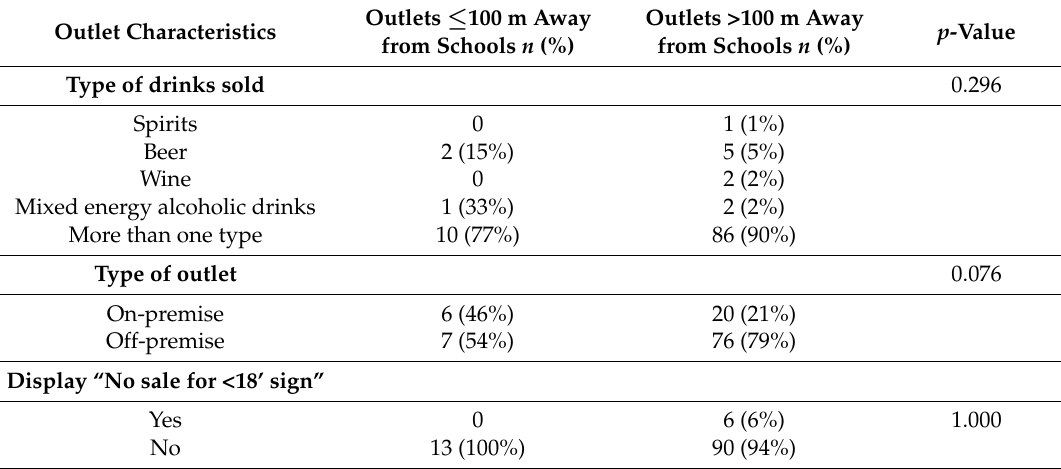
Table 4. A comparison between the outlets that are close to schools vs. those that are more distant to